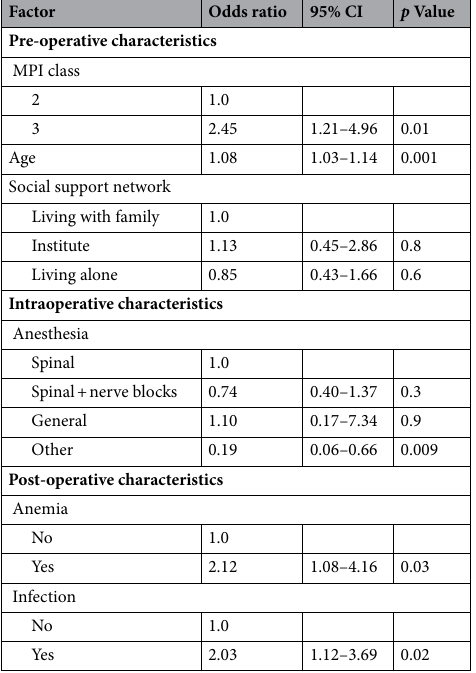
Factor Odds ratio 95% CI p